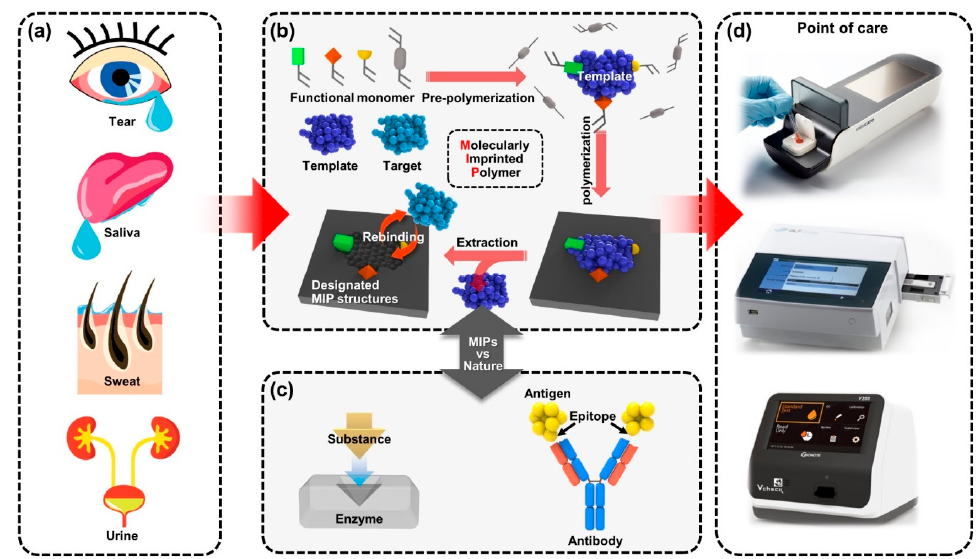
Figure 1. A new class of benchtop-scale POCT devices utilized by MIP-based biosensors for precision diagnostic technology to detect biomarkers in biofluids. ( a ) The four types of representative human biofluid reflecting health conditions; tears, saliva, sweat and urine. ( b ) Schematic illustration for fabricating the molecular imprinting system that contains the biorecognition sites and ( c ) the example of natural biorecognition system; enzyme–substrate complex ( left ) and antigen–antibody reaction ( right ); the biomimetic functional similarity of the MIP biosensing system is comparable to natural antibodies. ( d ) Various types of immunoassay-based benchtop-scale POCT devices.